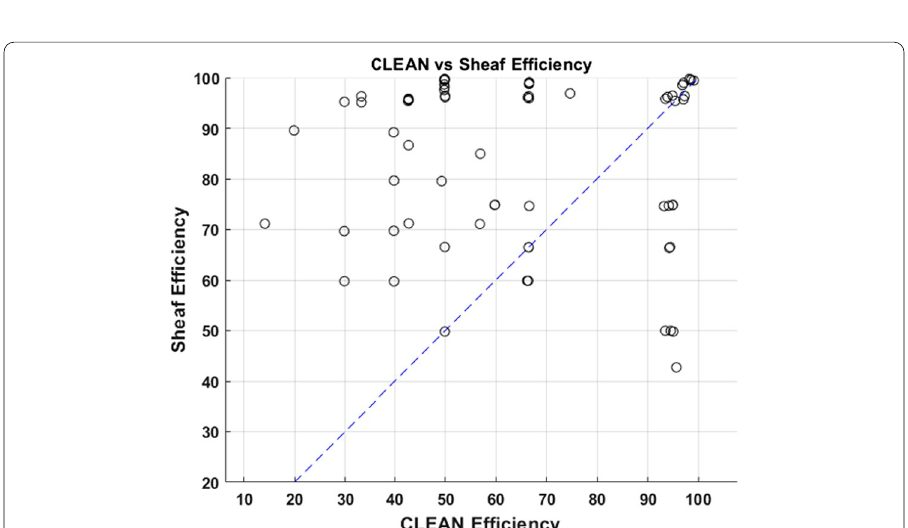
Fig. 8 Efficiency of the sheaf algorithm versus the CLEAN algorithm. The dashed line is the diagonal (equal efficiency from both